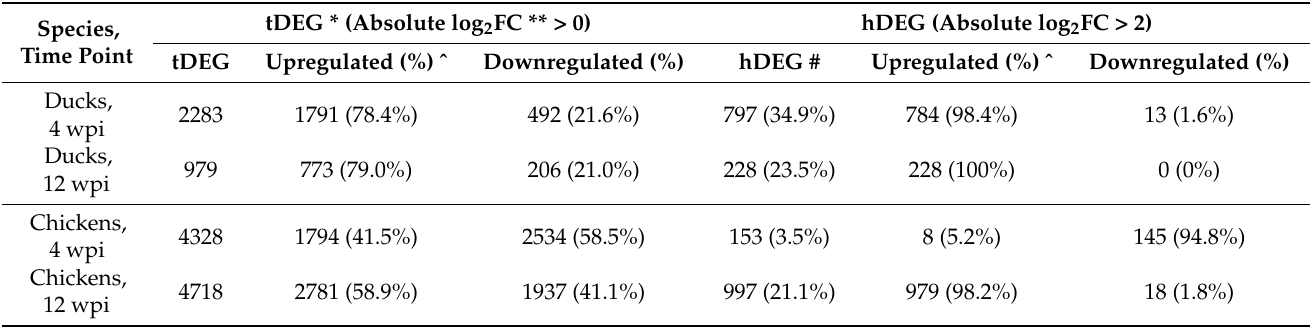
Table 2. Total (tDEG) and highly (hDEG) differentially expressed genes in the brains of ABBV-1- infected Muscovy ducks and